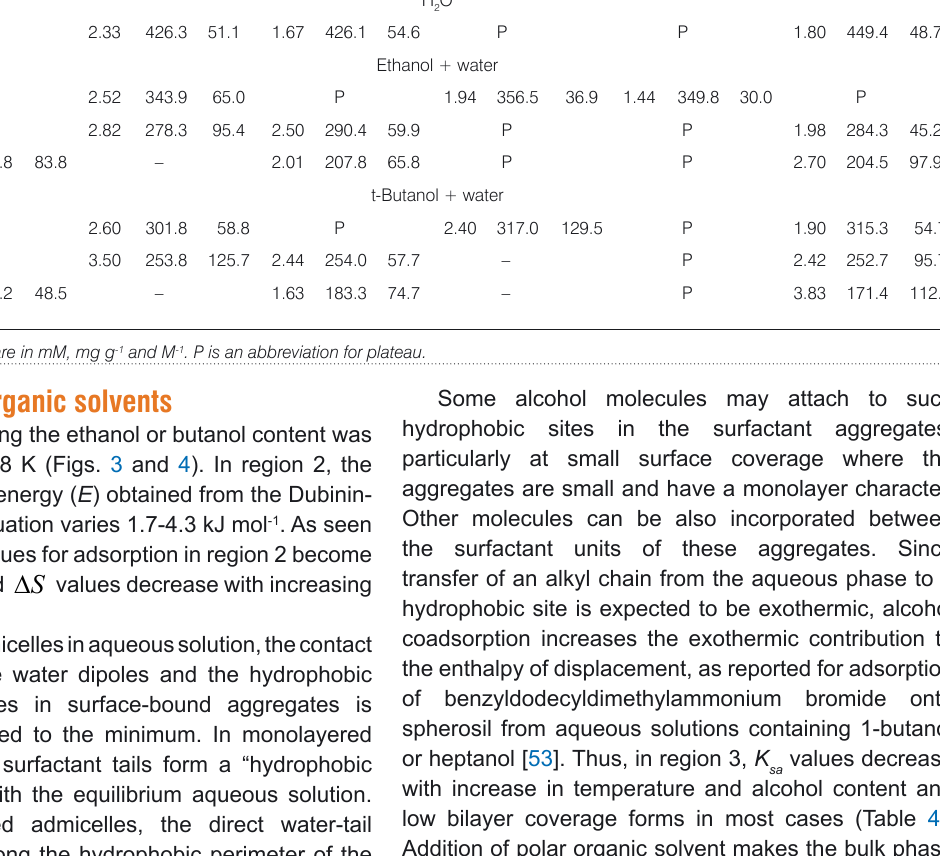
and k values obtained from the reverse srd rd